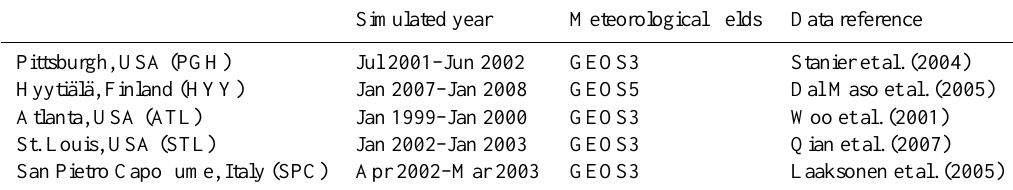
Table 1. Locations for model